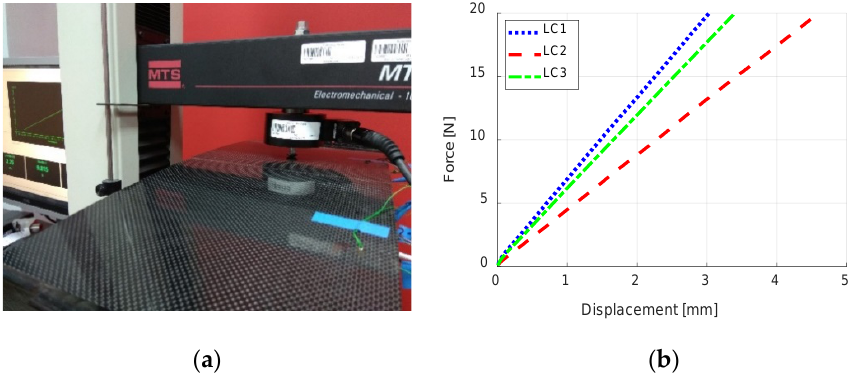
Figure 6. Load points in experimental verification.